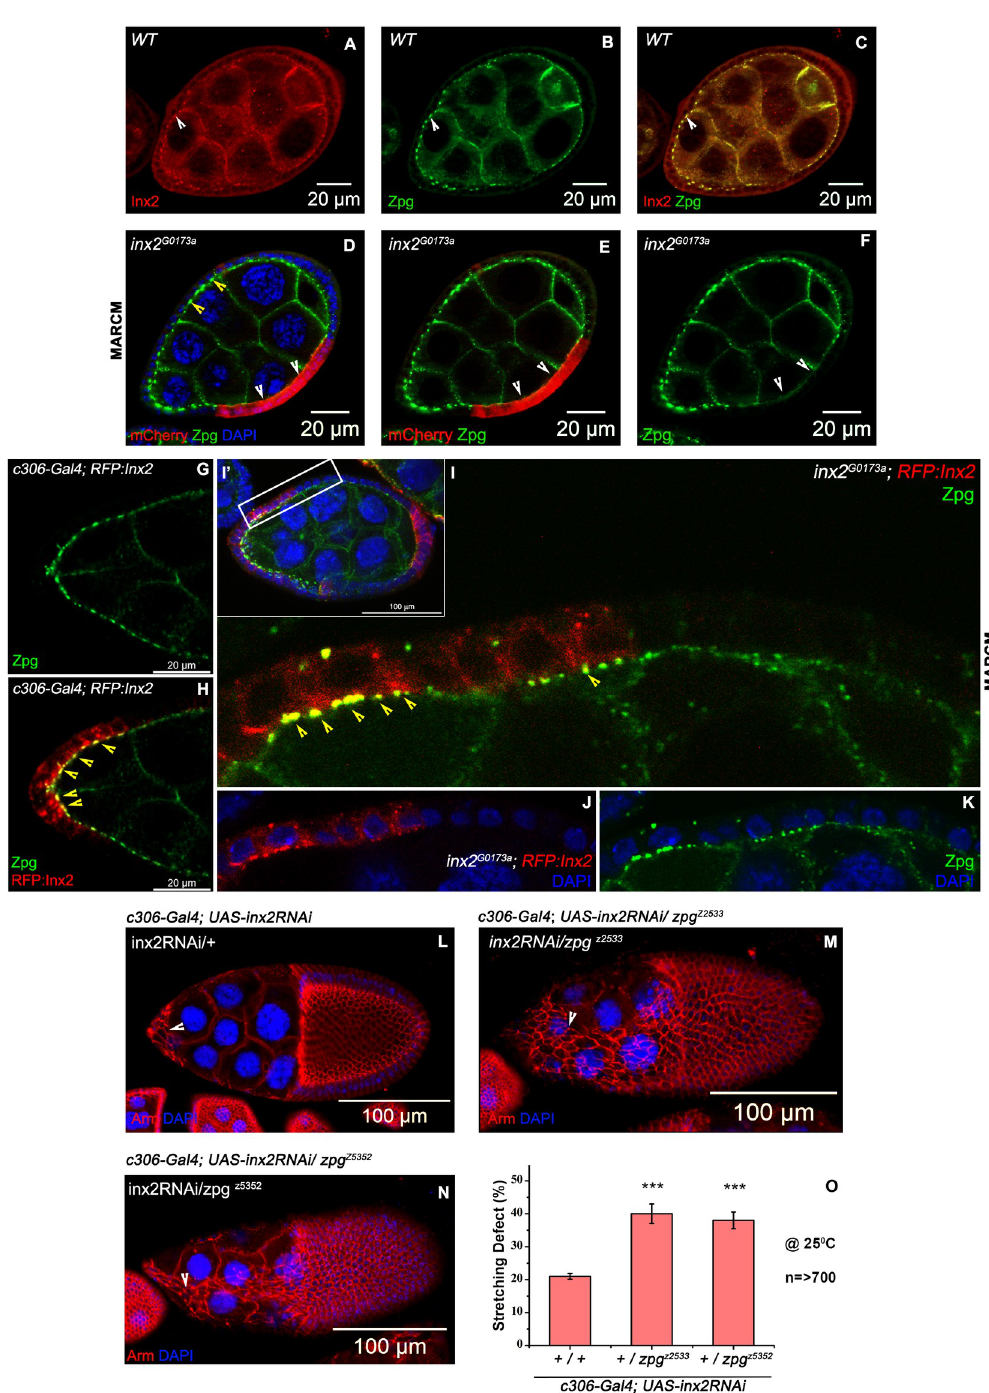
Fig 7. Partial co-localization and genetic interaction between Inx2 and Zpg. (A-C) Expression pattern of Inx2 and Zpg in the wild type (CsWT) egg chambers. White arrowhead marks respective proteins. (A) Inx2 in Red. (B) Zpg in Green. (C) Merge of A and B. (D-F) MARCM analysis. inx2 G0173a mutant follicle cells are marked with mCherry imaged in Red and Zpg is shown in Green. Note the reduction in the levels of Zpg at the Nurse Cell-Follicle Cell interface (White arrowhead). Yellow arrowhead in D. marks the Zpg expression in the inx2 G0173a /+ follicle cells. (G-H) Stage 8 egg chambers of indicated genotype. (G) Zpg is in Green (H) Merge of Red in RFP:Inx2 and Zpg is in Green. Yellow arrowhead mark the colocalization of RFP:Inx2 and Zpg at the interface of follicle and nurse cell boundary. (I-K) MARCM analysis. (I’) Stage 8 egg chambers carrying clones of inx2 G0173a mutant AFCs that are overexpressing RFP:Inx2. (I-J) Magnified image of the Boxed outline in